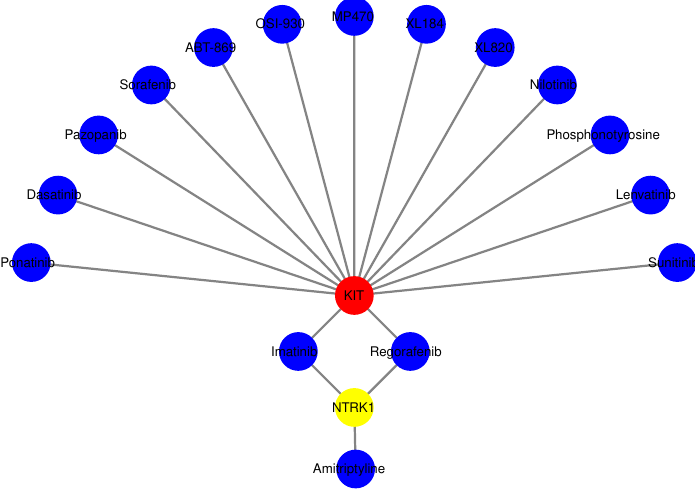
Figure 9. Gene miRNA is identified between T2D and Smoking using 2 different algorithm called TarBase and MirTarBase.